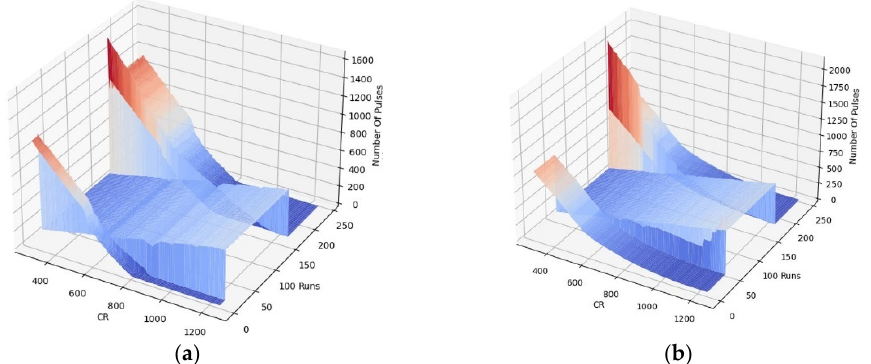
Figure 10. A snapshot of the GUI.